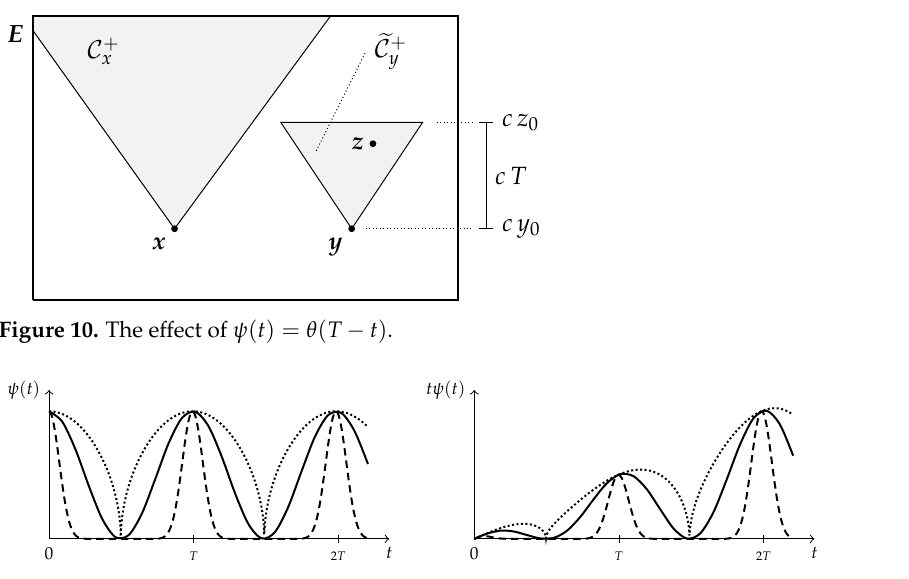
Figure 11. ( Left ): three periodic form factors, solid line ψ ( t ) = cos 2 ω t , dashed line (stricter) ψ ( t ) = cos 20 ω t , dotted line (looser) ψ ( t ) = the causal